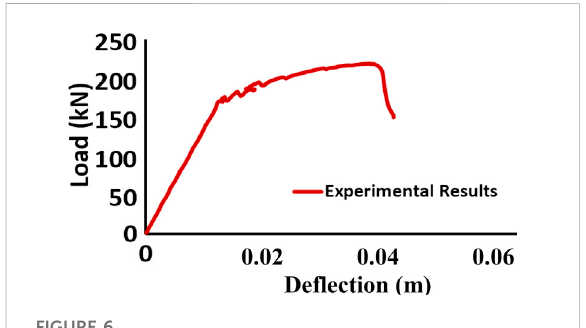
FIGURE 6 Crack-Time behaviour of RCB with 25% bottom ash.